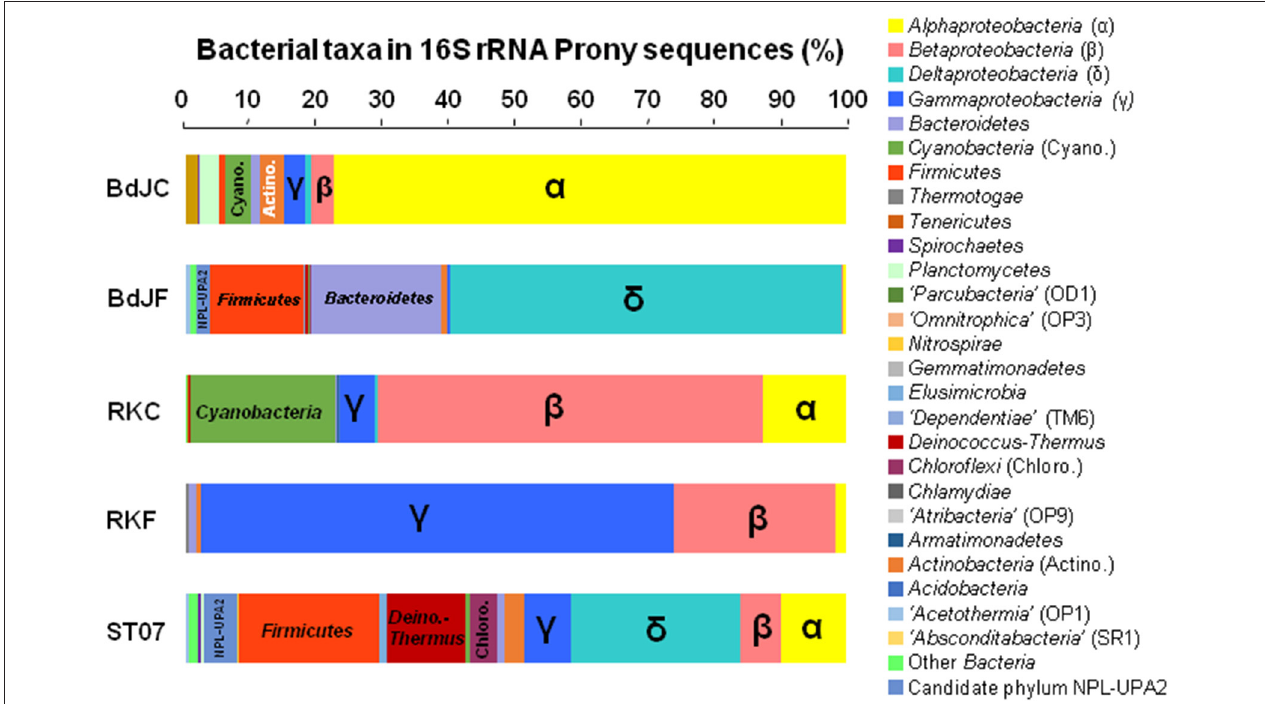
FIGURE 5 | Distribution and taxonomic assignments of 16S rRNA bacterial sequences in chimneys and fluids of interdidal and submarine sites of PHF. Relative phylogenetic abundance was based on frequencies of the 16S rRNA gene sequences (with respect to the total number of sequences obtained by pyrosequencing) affiliated to major phylogenetic phyla or class in the bacterial communities of the “Bain des Japonais” (BdJ), “Rivière des Kaoris” (RK), and the “Aiguille de Prony” (ST07). The suffix “C” in sample names corresponds to “chimney” and the suffix “F” corresponds to “fluid.” The abbreviations of phyla and the former names of candidate phyla are indicated in